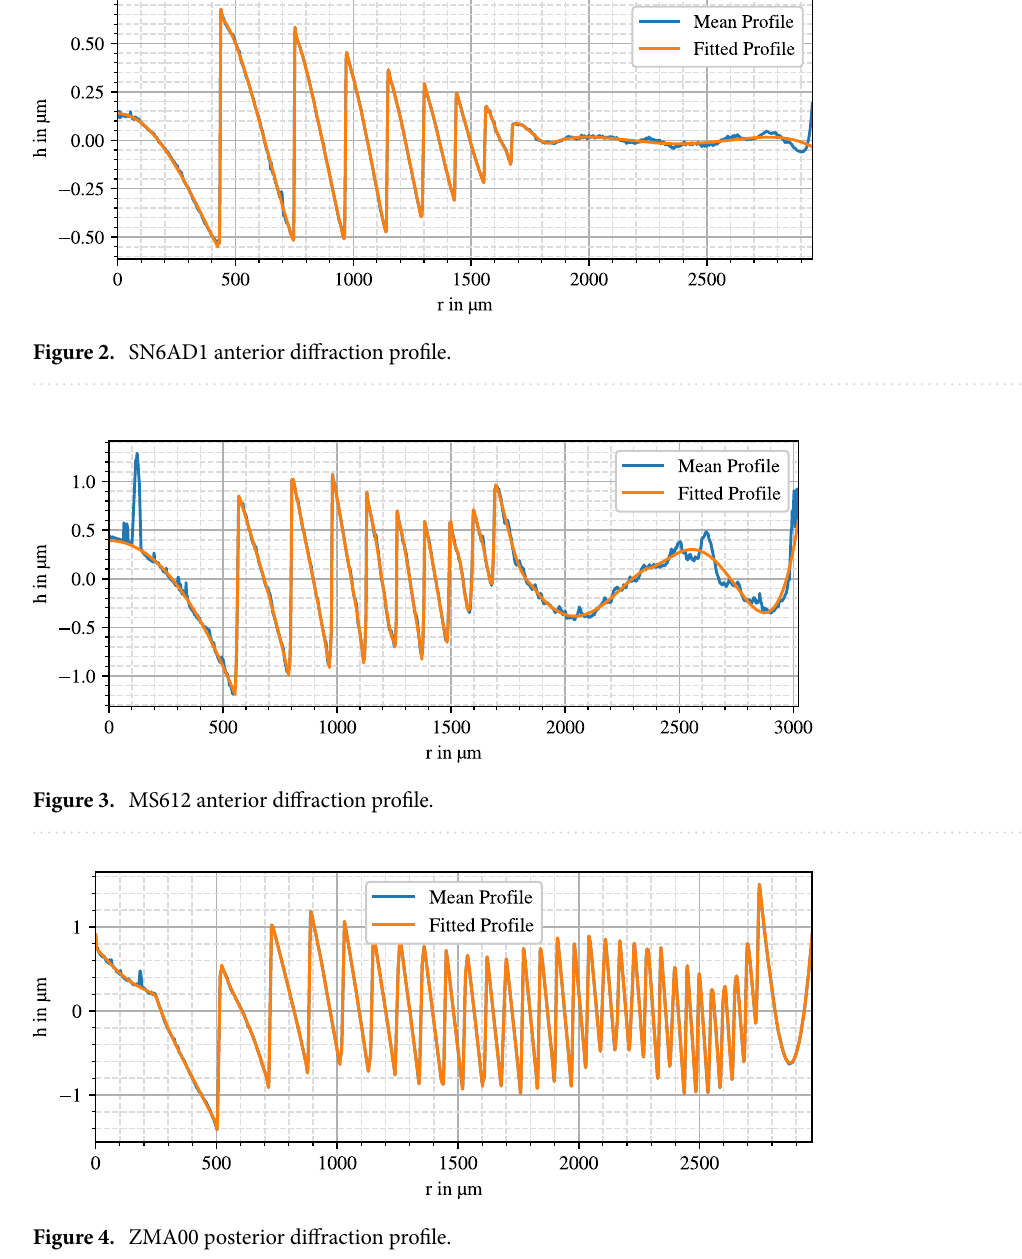
Figure 4. ZMA00 posterior diffraction